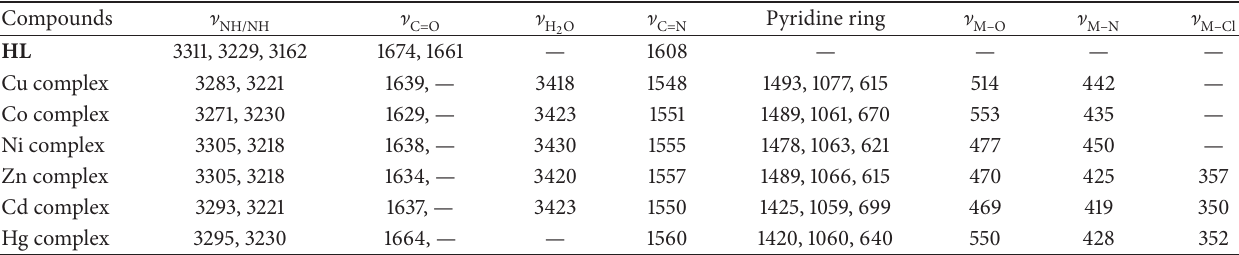
Table 2: The IR data of ligand HL and its complexes (cm − 1